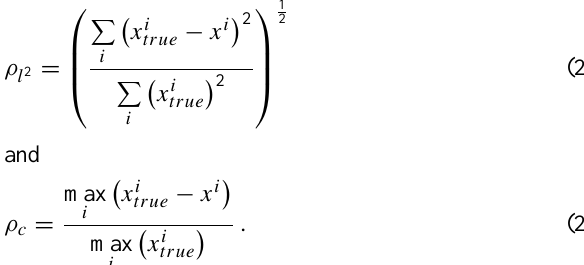
Fig. 4. GSVD reconstructed mid-latitude ionosphere for ( a ) quiet